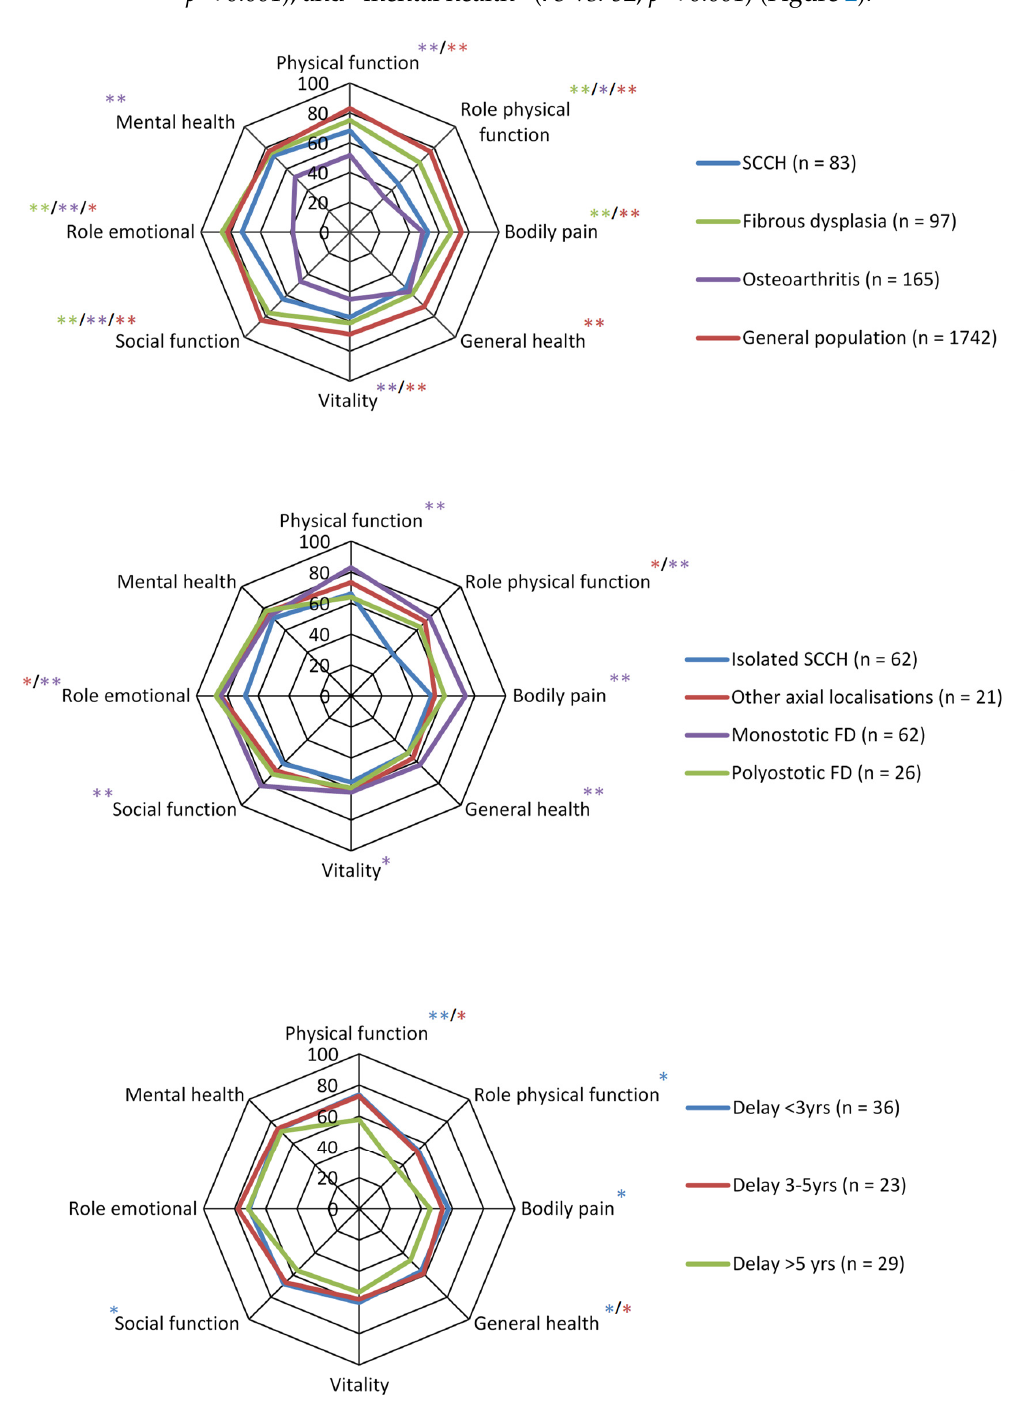
Figure 2. Radar charts comparing QoL Short Form-36 scores between CNO/SCCH patients and the general Dutch population, Fibrous Dysplasia (FD) and Osteoarthritis patients (OA), between subtypes of CNO/SCCH (isolated SCCH vs other axial localisations) and FD (isolated SCCH vs. monostotic FD), and between the length of delay in diagnosis (<3 yrs/3–5 yrs and >5 yrs) to a longer delay in diagnosis (>5 yrs). Significance was illustrated by * p < 0.01 or ** p < 0.001. The colors represent different subgroups in the different spider graphs.